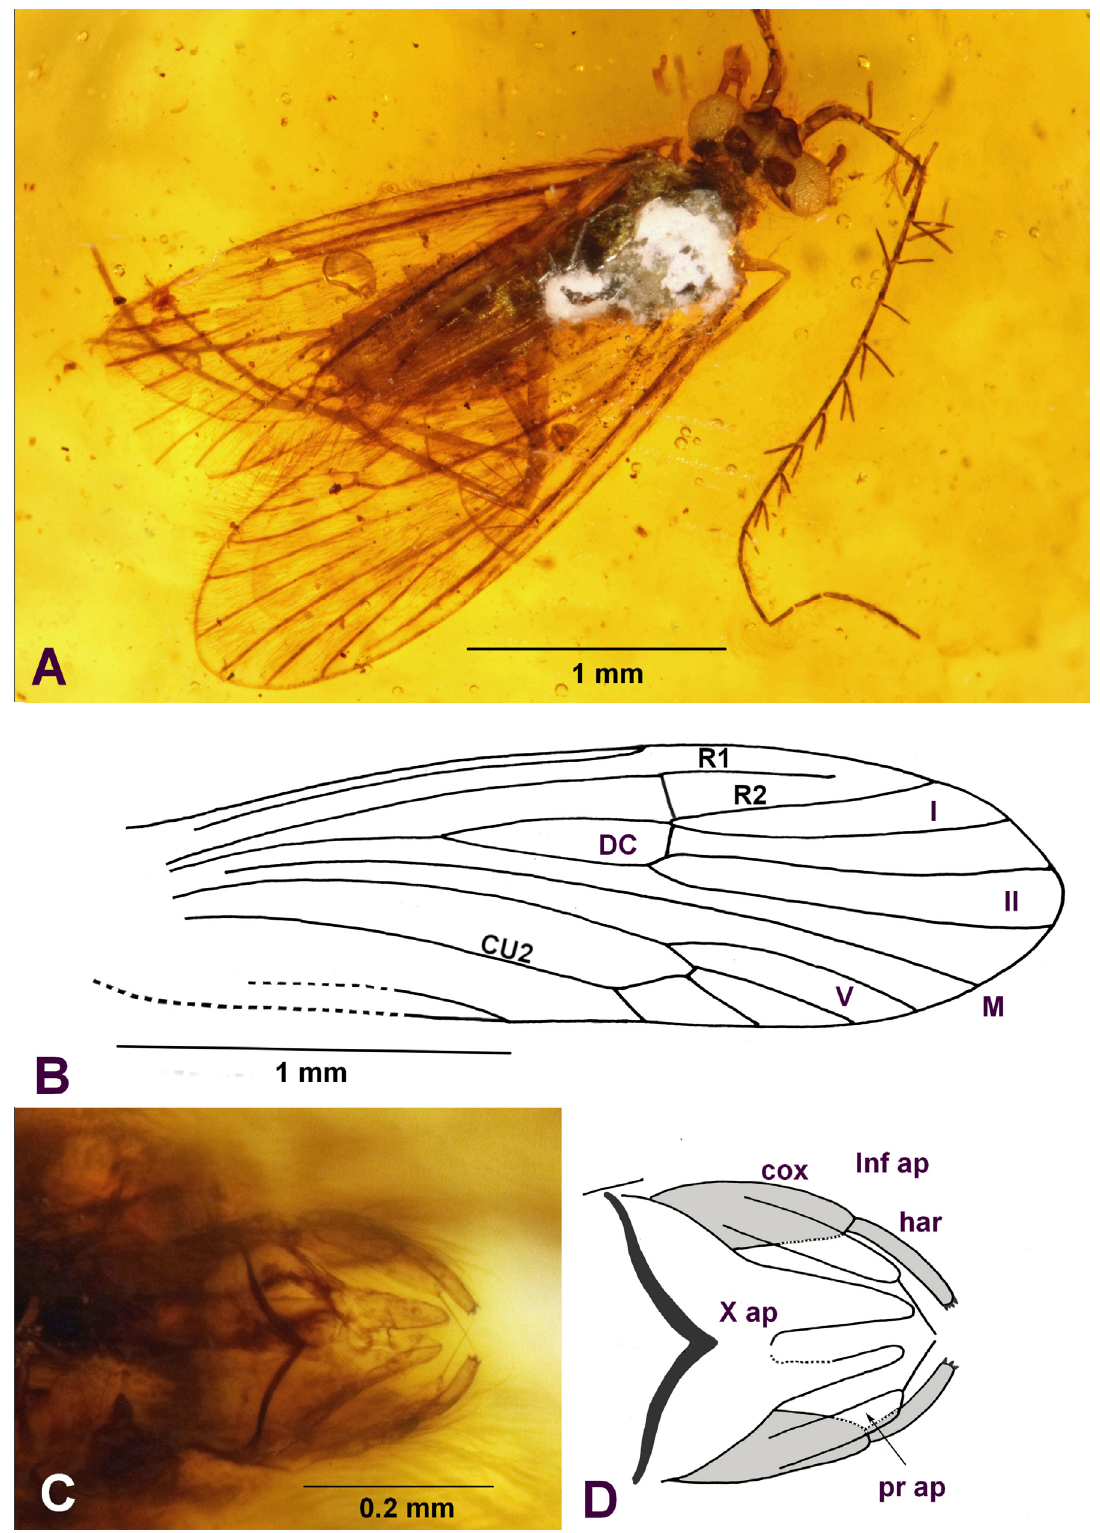
Fig. 1. Palaeopsilotreta xiai Wichard & Wang, 2017. A . Male with bipectinate antennae in dorsal view (ZFMK-TRI000811). B . Drawing of a forewing. C . Male genitalia in dorsal view (ZFMK-TRI000812). D . Drawing of the male